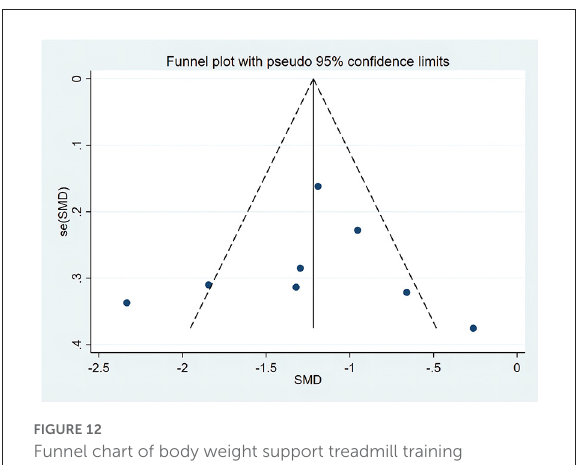
FIGURE12 Funnel chart of body weight support treadmill training combined with functional electrical stimulation intervention and body weight support treadmill training in Fugl-Meyer Assessment